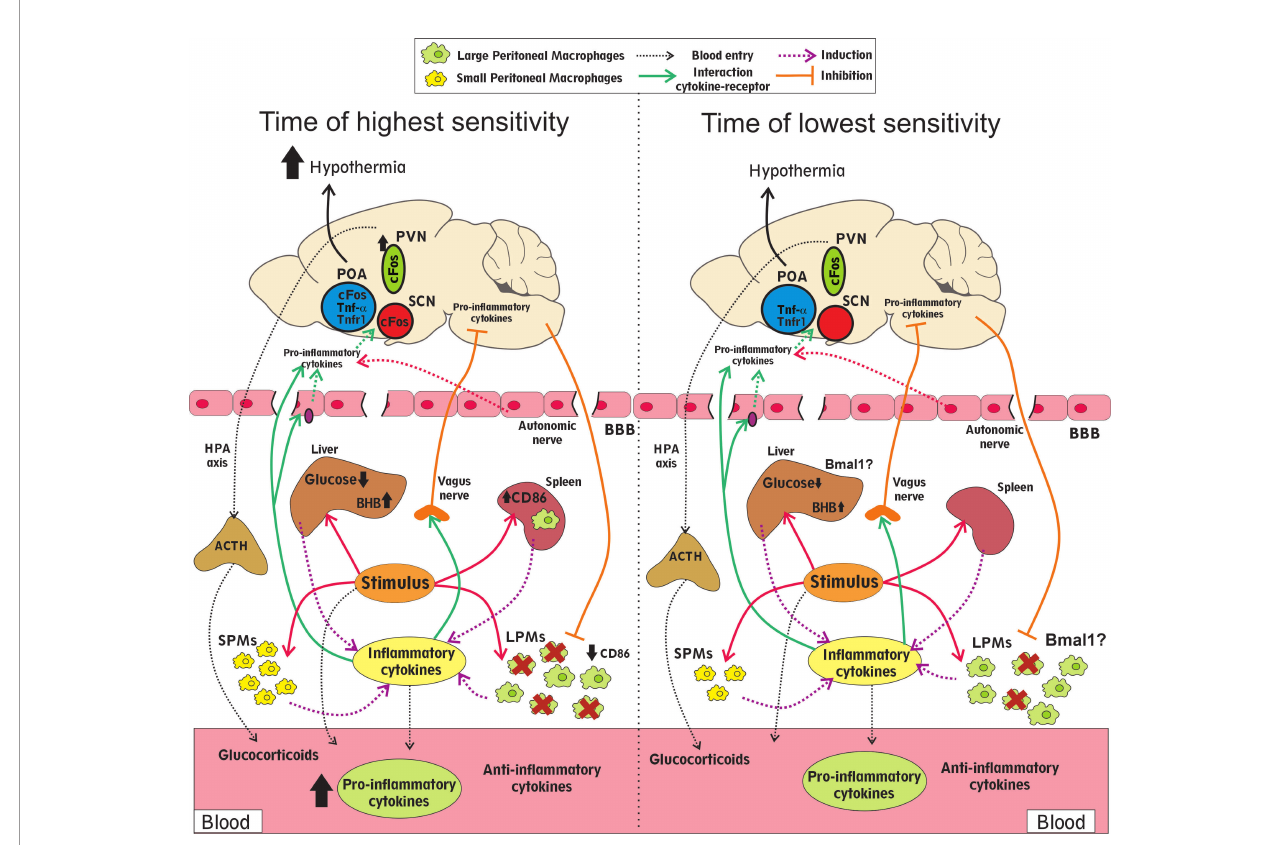
FIGURE 1 | Differential features observed at times of higher and lower mortality rates. Infectious stimuli impact the peritoneal macrophages (SPMs and LPMs), in the liver and the spleen, secreting higher cytokine levels to the blood at the time of higher mortality. This difference could be related to the higher basal SPMs counts and higher activated (CD86) splenic macrophages after stimulation. The decrease in the LPMs count (MDR) is also higher at the time of the worst prognosis. The anti- in fl ammatory mediators glucocorticoids and IL10 increase similarly at both times. The decrease in glucose and the increase in b -hydroxybutyrate (BHB) levels were more pronounced at the moment of higher mortality and depending on the liver rhythms. Neuronal activation (cFos) of brain regions that control body temperature (POA, SCN and PVN), and the subsequent hypothermia, were also increased at the time of poor prognosis. Communication between the central nervous system and peripheral tissues during sepsis includes the HPA axis and the autonomic nerves, particularly the vagus nerve. The brain blood barrier (BBB) can receive in fl ammatory signals and secrete cytokines into the brain. In addition, the in fl ammation that occurs during sepsis can disturb this barrier and increase its permeability. The expression of the clock gene Bmal1 in the liver and the myeloid cells is associated with a better